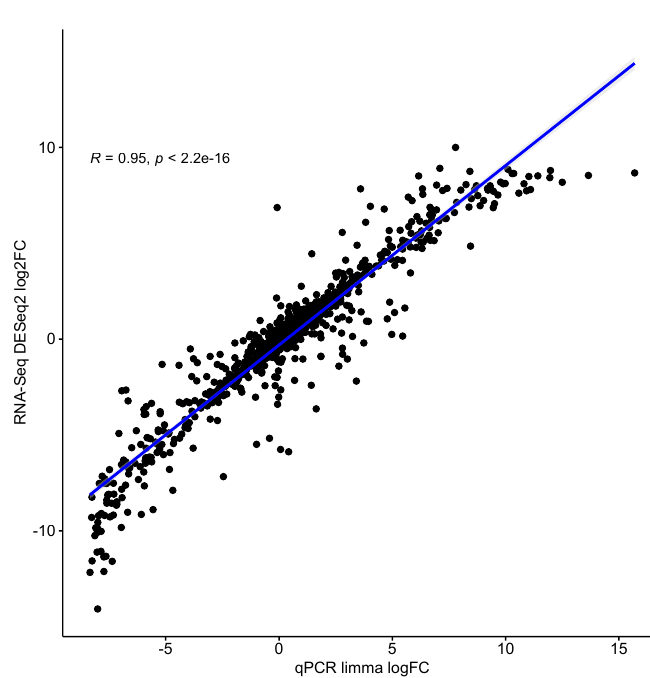
Figure A1. Logarithmized fold change correlation between limma results of qRT-PCR and pipeline results ( DESeq2 ) of RNA-Seq data with no filter. The correlation was calculated by the Pearson coefficient.